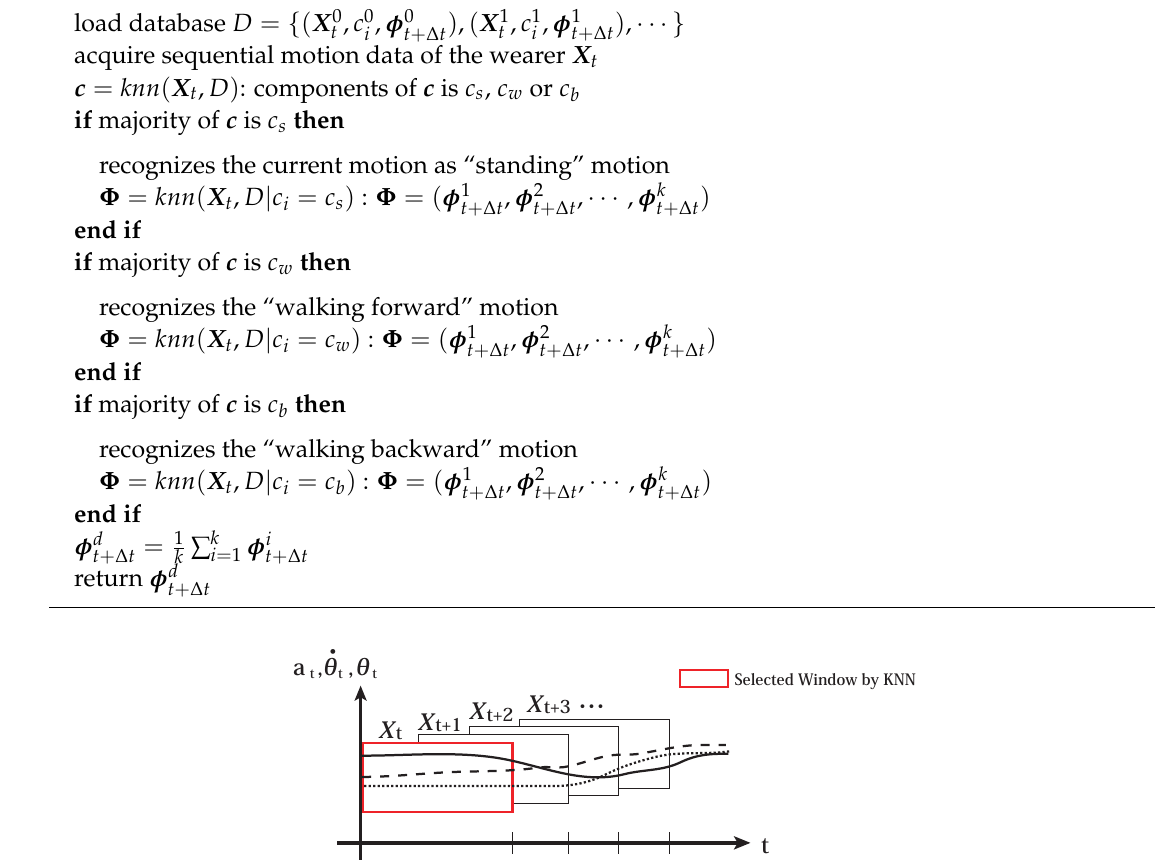
Algorithm 1 Wearer’s motion estimation, and calculation of joint angle of powered exoskeleton